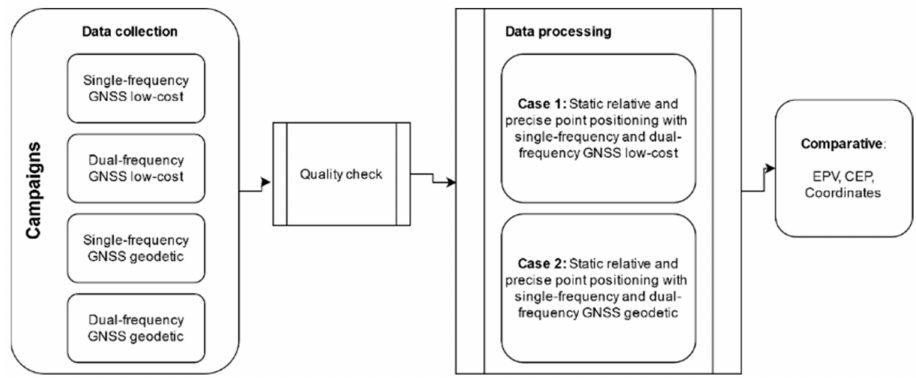
Figure 3. Flowchart depicting Methodology adopted.